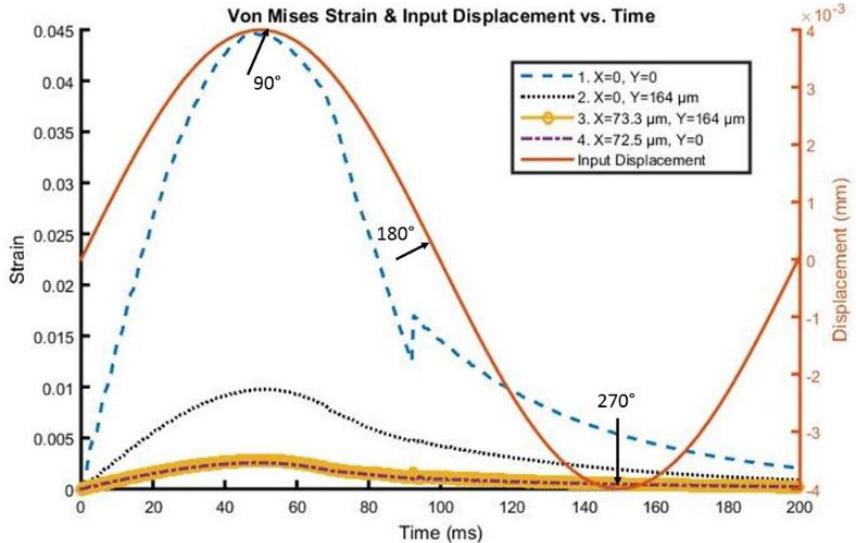
Figure 5. Von Mises Strain versus time along the interface of the Silicon probe with the brain.